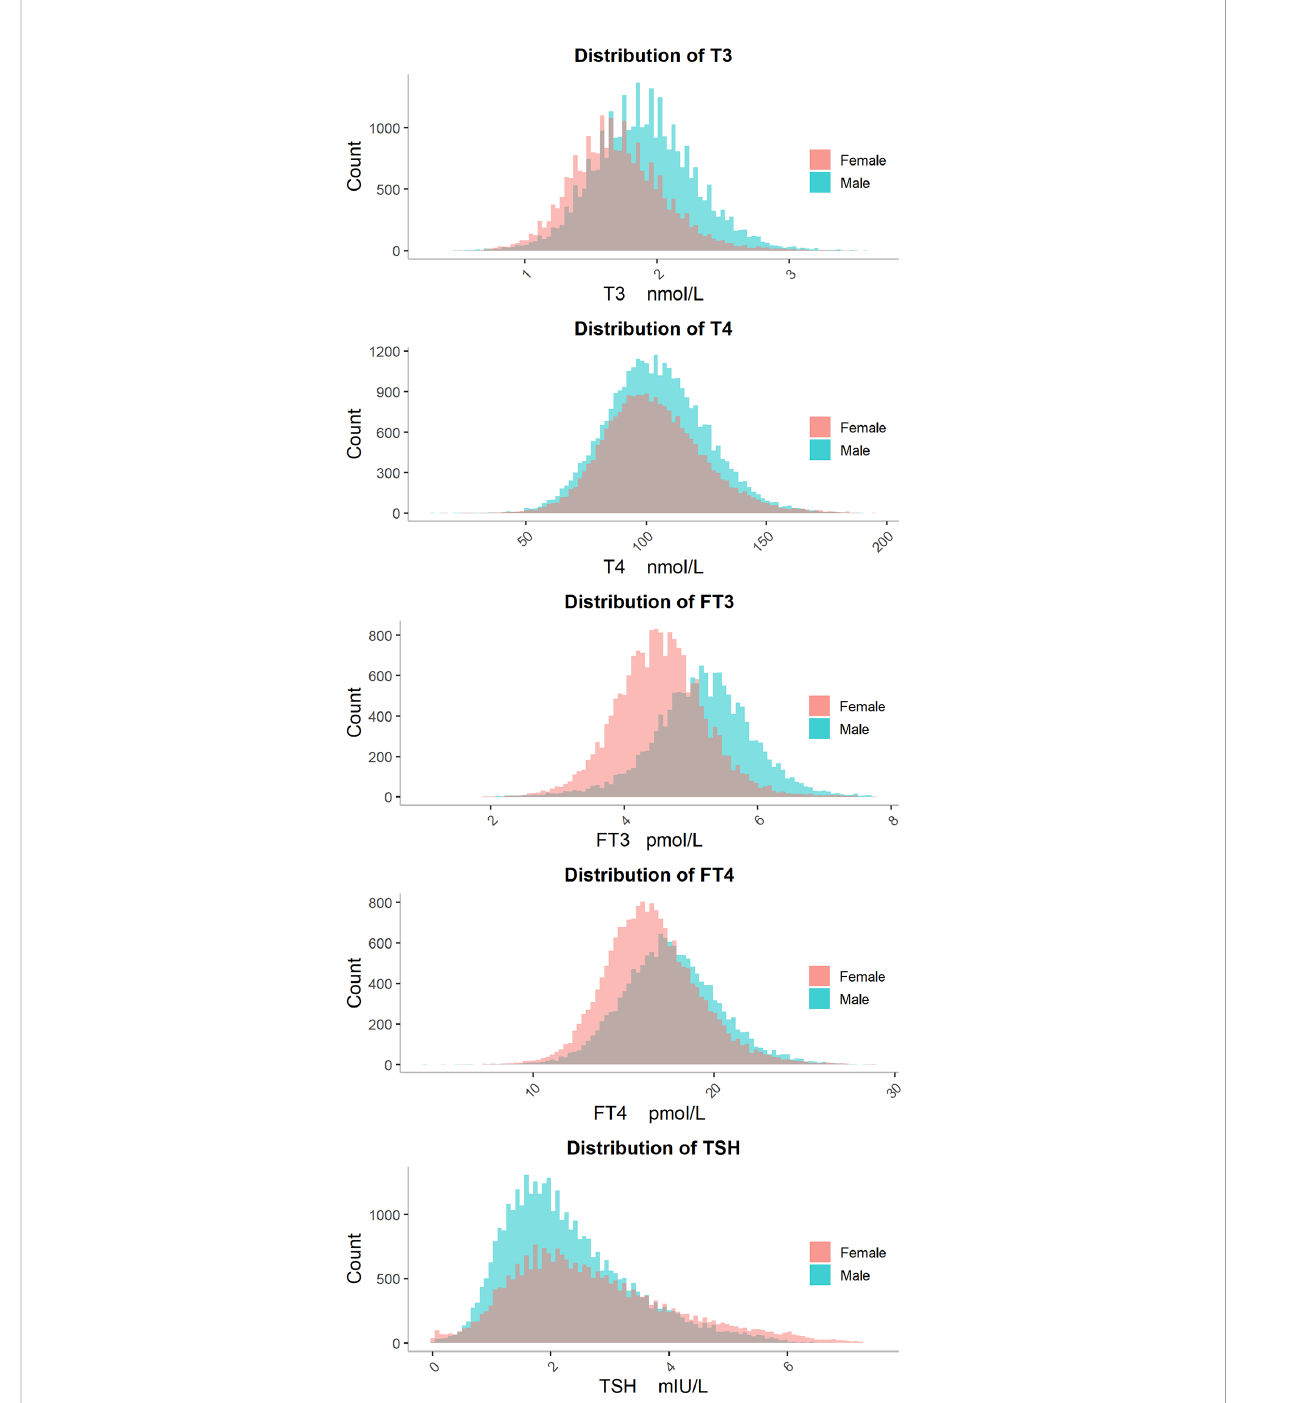
FIGURE 1 The distributions of T3, T4, FT3, FT4 and TSH. The distributions of fi ve thyroid hormones are shown separately for males (blue bars) and females (red bars). Abbreviations are listed in the legend of Table